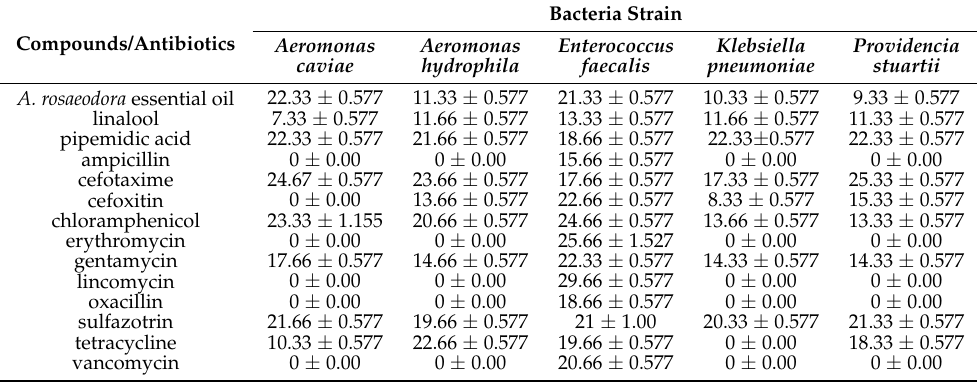
Table 2. Inhibitory zone diameters of Aniba rosaeodora essential oil, linalool and antibiotics on different bacteria isolated from marine environment after 24 h of treatment.